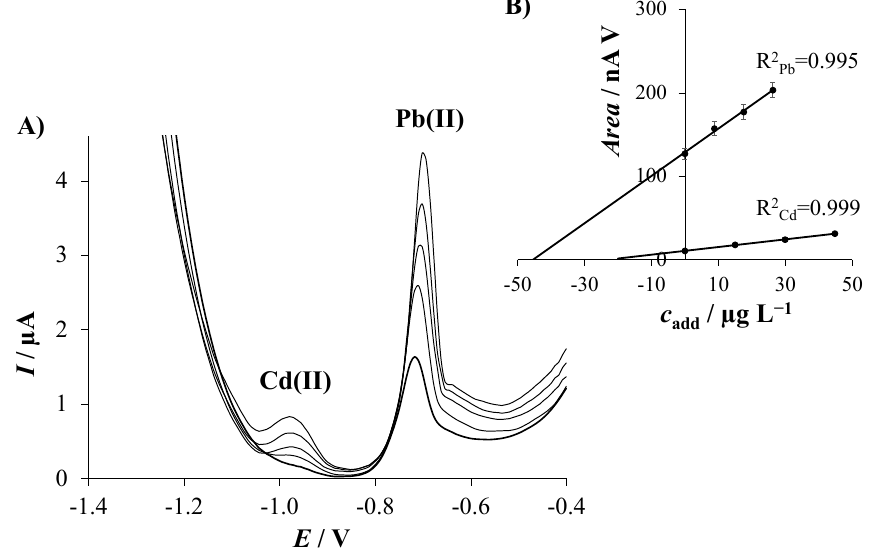
Figure 6. ( A ) Stripping voltammograms for simultaneous determination of Cd(II) and Pb(II) ions in a certified estuarine water reference material sample using 2D Sb exf -SPCNFE at pH 2, E d of − 1.4 V, and t d of 240 s; and ( B ) linear regression plots of the standard addition